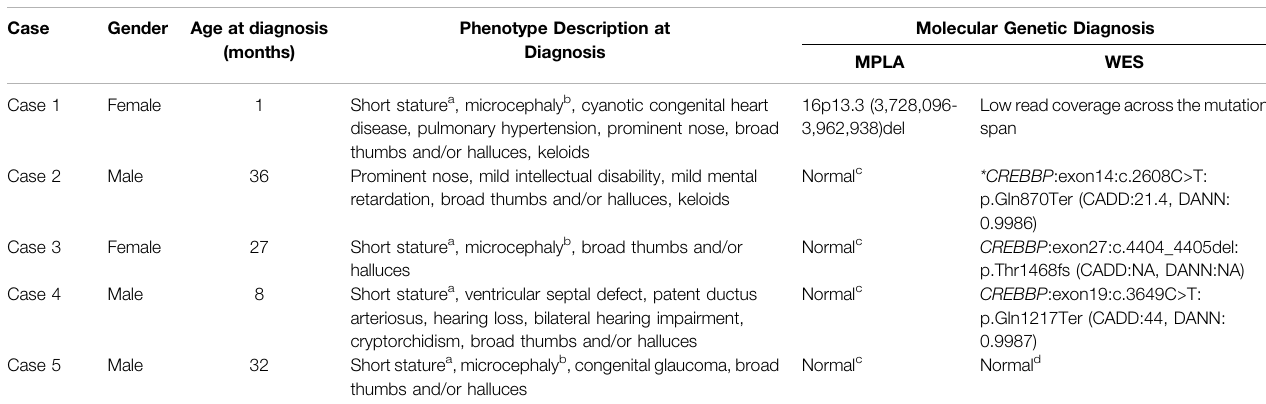
TABLE 1 | Summary of causative genetic alterations found in this study.